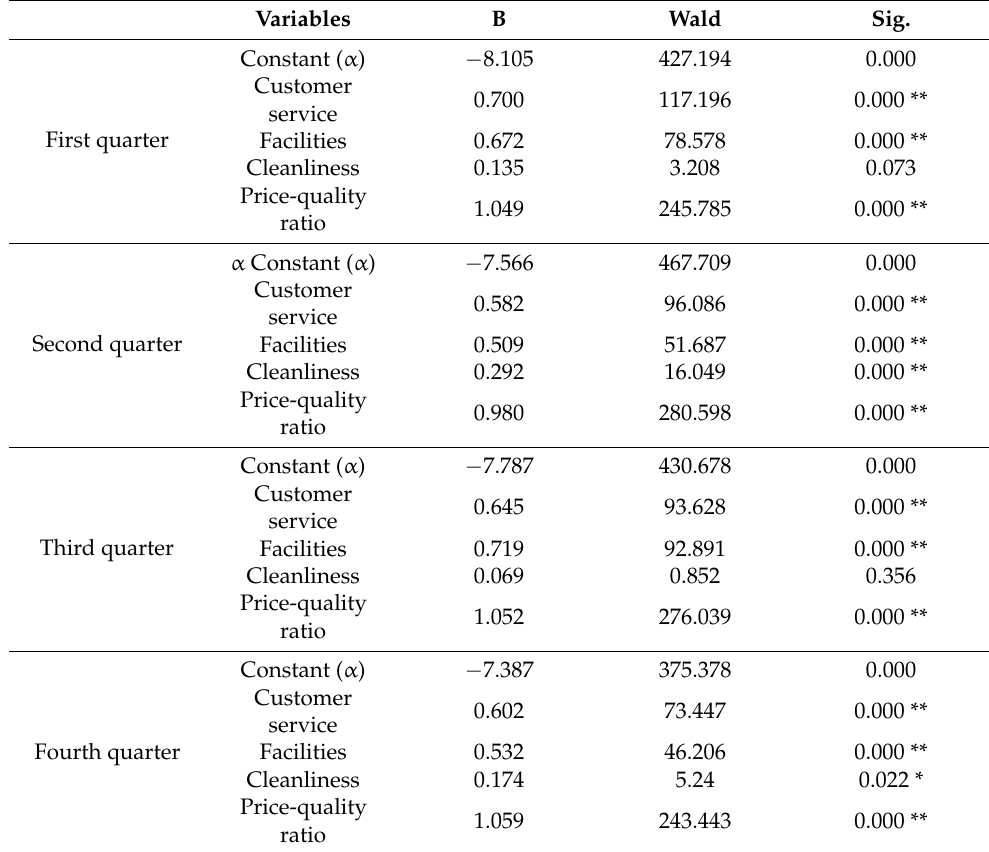
Table 4. Results of the logit regression for each